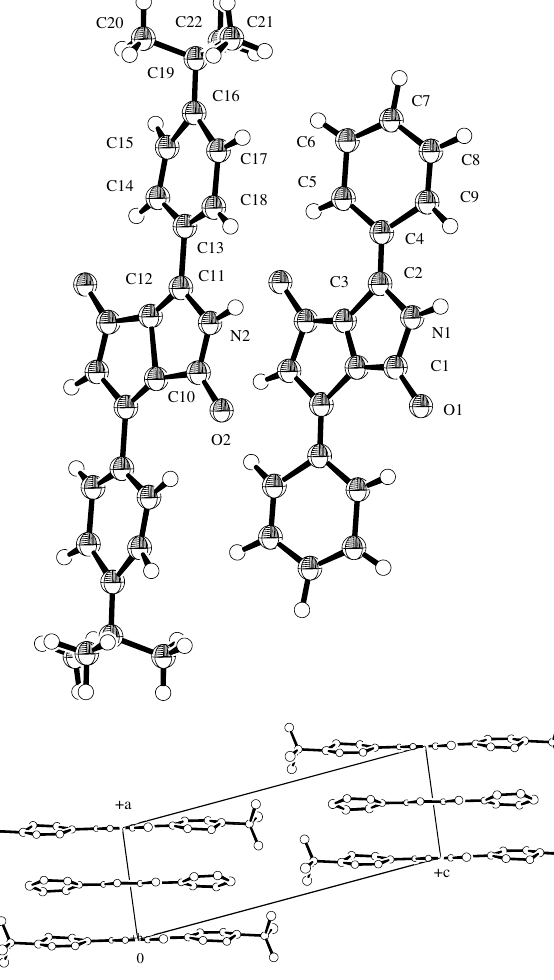
Specialty Chemicals. The 1:1 mixed crystal (MX-DPP) was pre- pared by deprotonation of DPP and BTB-DPP with sodium